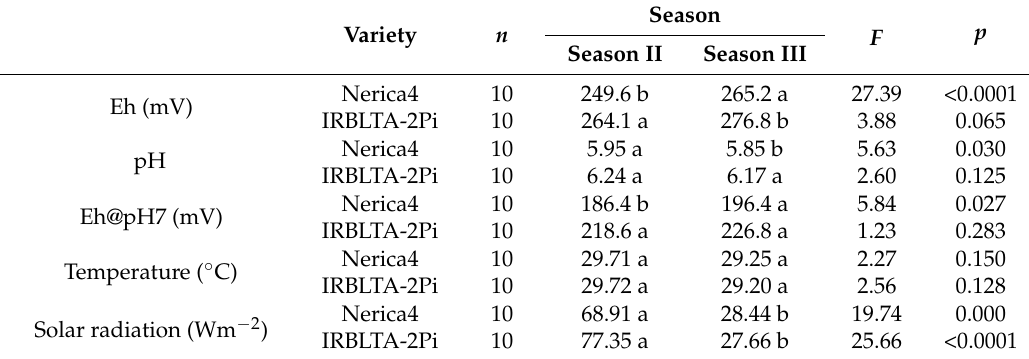
Table 3. Means and pairwise comparisons of Eh, pH, Eh@pH7, temperature and solar radiation intensity in two growing seasons (II and III) for 59–60-day-old plants, for two rice varieties (Nerica 4, IRBLTA2Pi). Plants were sown 25 April 2016 in season II and 12 August 2016 in season III, grown in aerobic conditions, fertilized with NPK. Measurements were made on the middle part of the last fully expanded leaf of the main tiller. F and p values of the ANOVA are indicated. Values followed by different letters indicate significant difference between seasons at 95% confidence interval (REGW- Q test). Variety